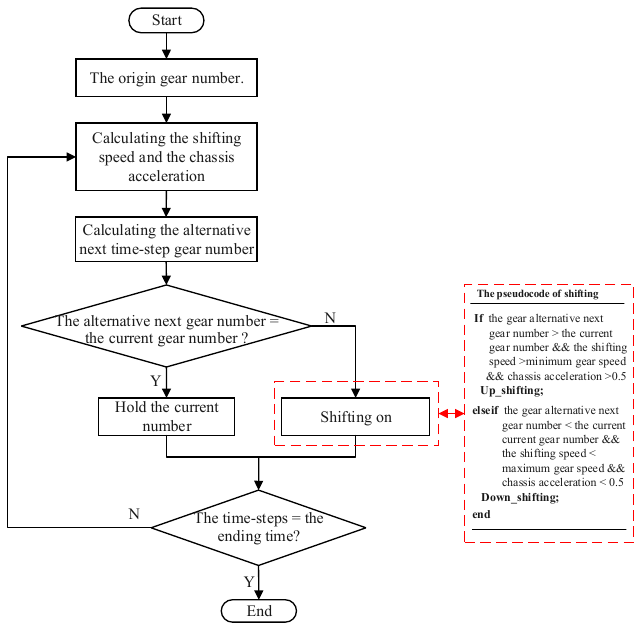
Figure 2. Gear shifting strategy.